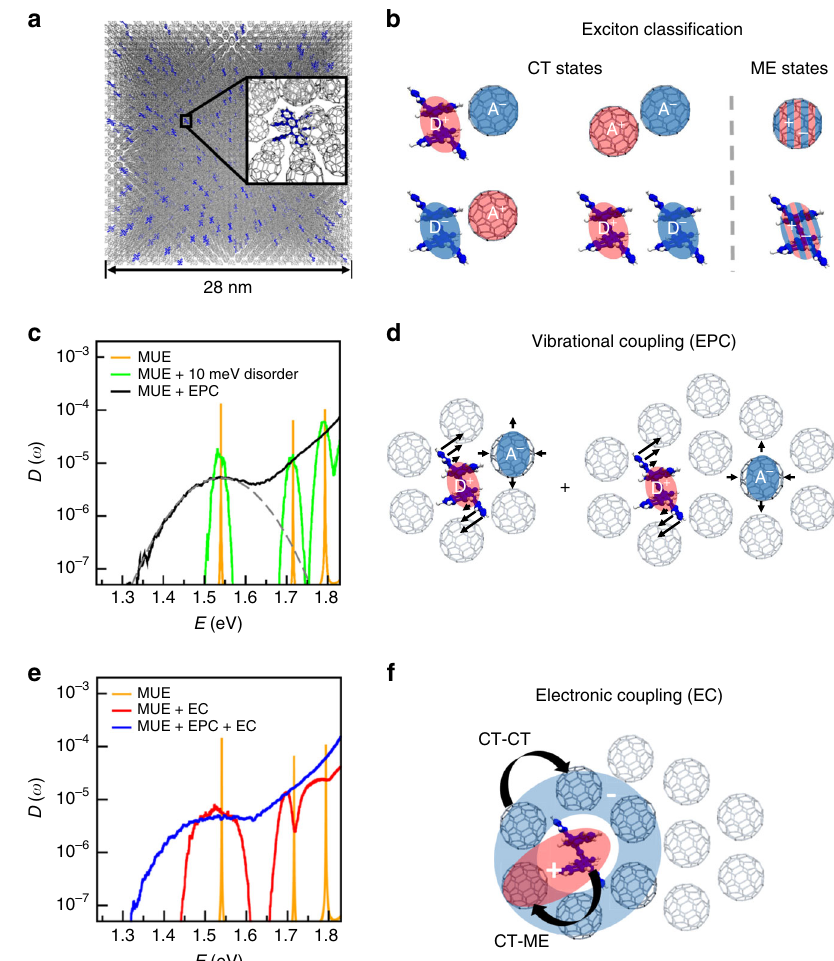
Fig. 1 First model system, excitonic density of states and schematics of excitonic states. a Perspective view to a rubrene:C 60 blend with a system size of around 40,000 molecules used for the EDOS simulations. Inset: zoom to a molecular cluster with a rubrene molecule as donor (ball and stick model) embedded in C 60 fullerene host molecules (stick model). Simulations are performed for 6 mol% donor concentration in a C 60 host. b Classi fi cation of excitons that are included in the simulations and contribute to the EDOS. “ A ” denotes the acceptor and “ D ” the donor compound, respectively. For simplicity, the charge separated states are included in the class of CT states (at large distance) and are not distinguished further in this scheme but also contribute to the EDOS. All the non-interacting electron – hole pairs considered here de fi ne the manifold of uncoupled excitons (MUE). c , e EDOS of different exciton models based on the rubrene:C 60 system to demonstrate different broadening mechanisms (disorder, electronic/excitonic coupling (EC) and EPC; see Supplementary Methods). d , f Illustration of the impact of different interactions (EPC, EC) on the states in the MUE. c Orange lines: EC and EPC are set to zero (MUE model). The peaks appear at analytical CT energies thus validating the numerical approach. The heights re fl ect the state degeneracies. The assumed numerical width is suf fi ciently small and not relevant. Green line: inhomogeneous disorder ( σ D = 10 meV for illustration purpose) broadens the CT-peaks of the MUE. Black line: room-temperature EDOS ( T = 300) including EPC, which induces a thermal linewidth of σ loc = ¼ 71 meV. e EDOS including EC between molecules assuming random C 69 meV. Dotted grey line: Gaussian fi t to the EDOS with σ num 60 orientation and loc random distribution of transfer integrals (Gaussian distributed with σ TI = 17 meV) and V D = 0. Red line: EDOS with zero EPC ( V ( T ) + V D = 0) yields a CT half-bandwidth of 90 meV. Blue line: EDOS including all microscopic interactions (EC and EPC); Orange lines indicate analytical energies from c